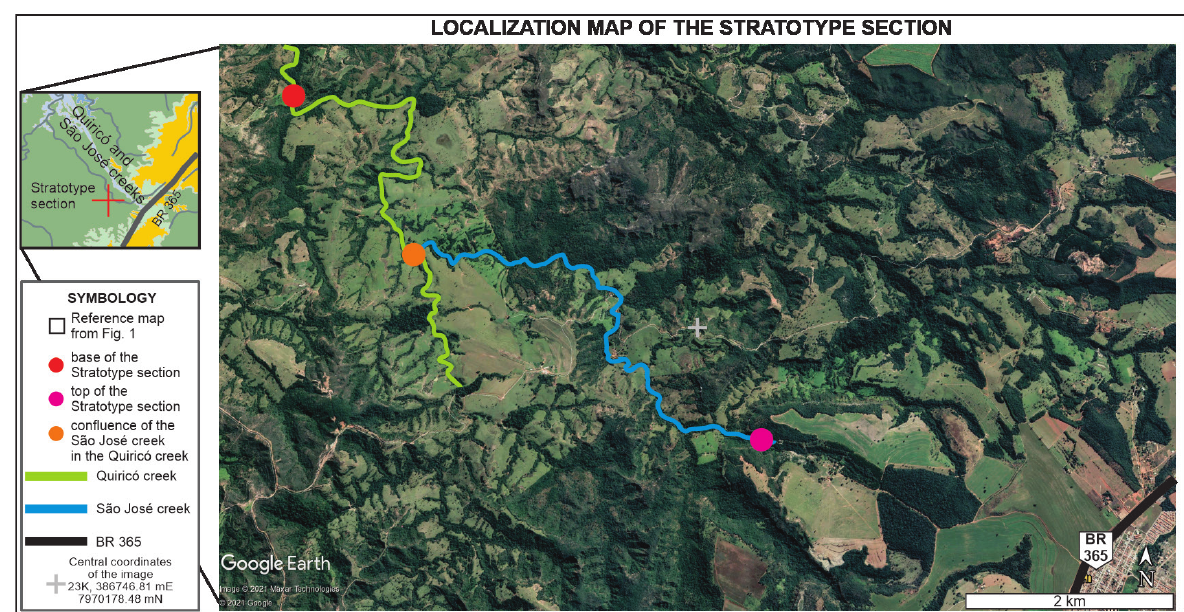
Figure 2. Localization map of the stratotype section of the Quiricó Formation. The base of the section is located in the banks of the Quiricó creek and the top of the section in the banks of the São José creek. Central coordinates of the image: 23K, 386746.81 mE, 7970178.48 mN (adapted from Google